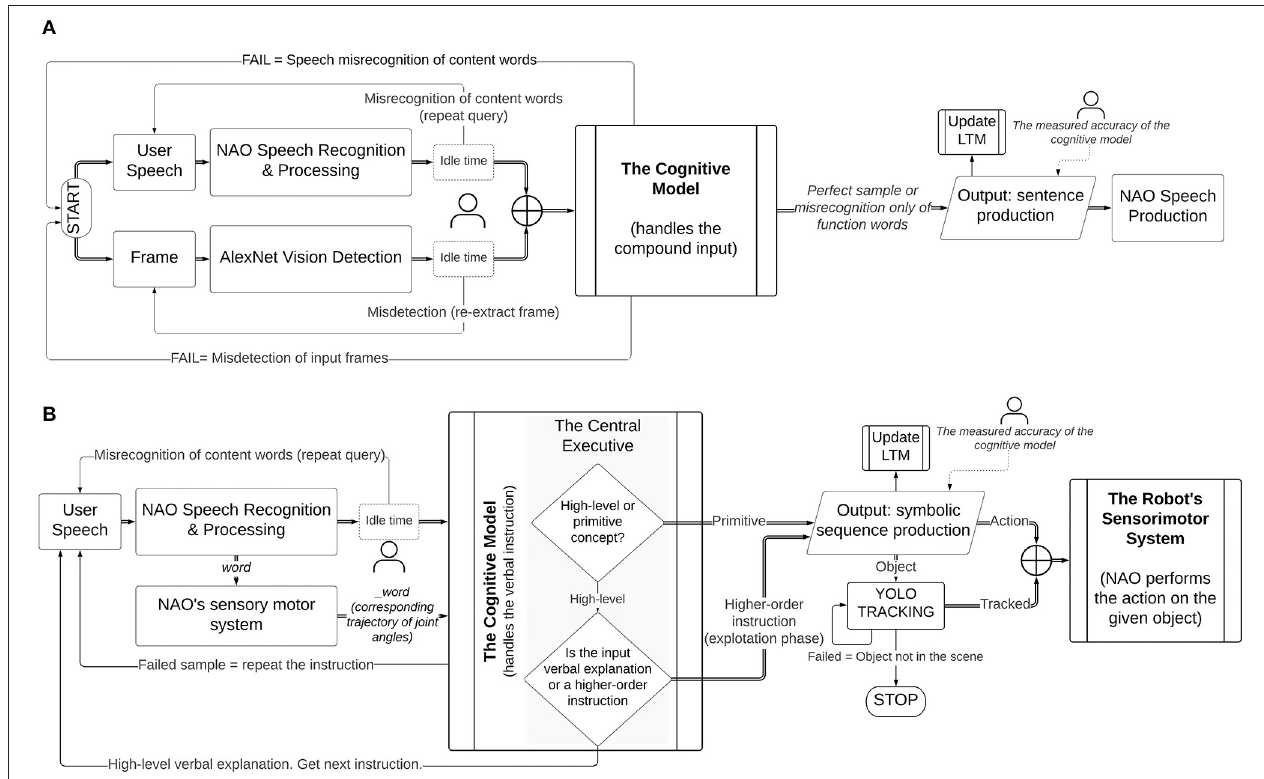
FIGURE 5 | Handling sensory-based inaccuracies during the runtime acquisition of target test data. In Perception Tasks (A) , the model takes the compound input from user speech, which is processed by NAO’s speech recognition module and, a vision input, captured by NAO’s cameras and classified by AlexNet. The human tutor loosely filters potential sensory errors to ensure ground-truth sample inputs at the cognitive model. In the event of a speech (content words) or vision misrecognition, the human re-captures the input. The accuracy is measured at the ends of the cognitive architecture only and is defined as the correctness of the output, assuming error-free input samples. Similarly, in Manipulation Tasks (B) , the cognitive model takes a pre-filtered compound input of speech samples and trajectory information from the robot’s motor map. The motor information is self-extracted from the robot and mapped to its symbolic representation without human supervision. This is fundamental for the test acquisition toolchain from primitive to high-level